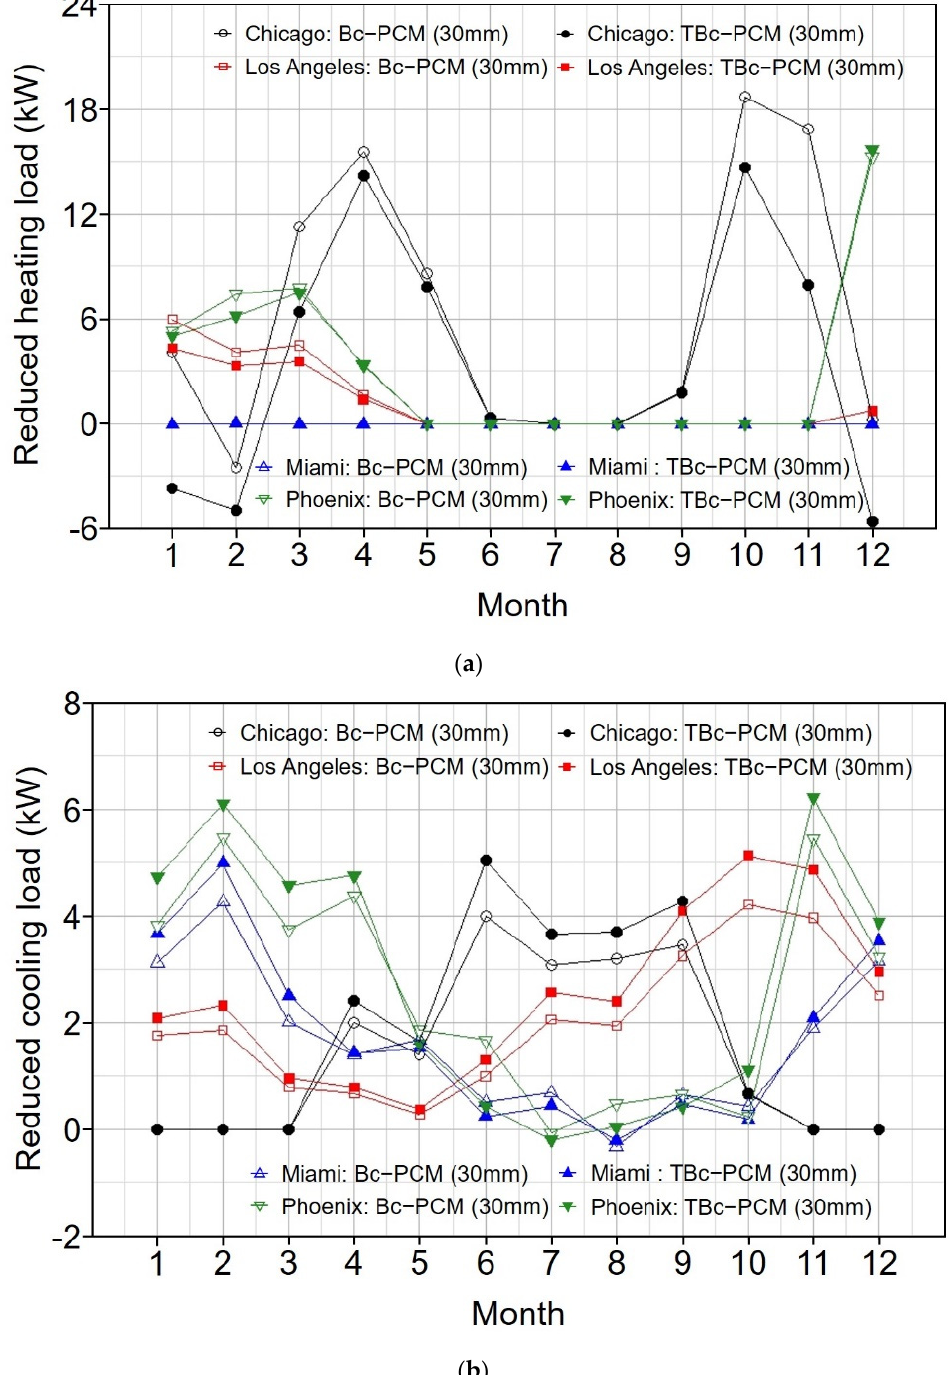
Figure 6. Monthly reduced ( a ) heating and ( b ) cooling energy load for four cities.